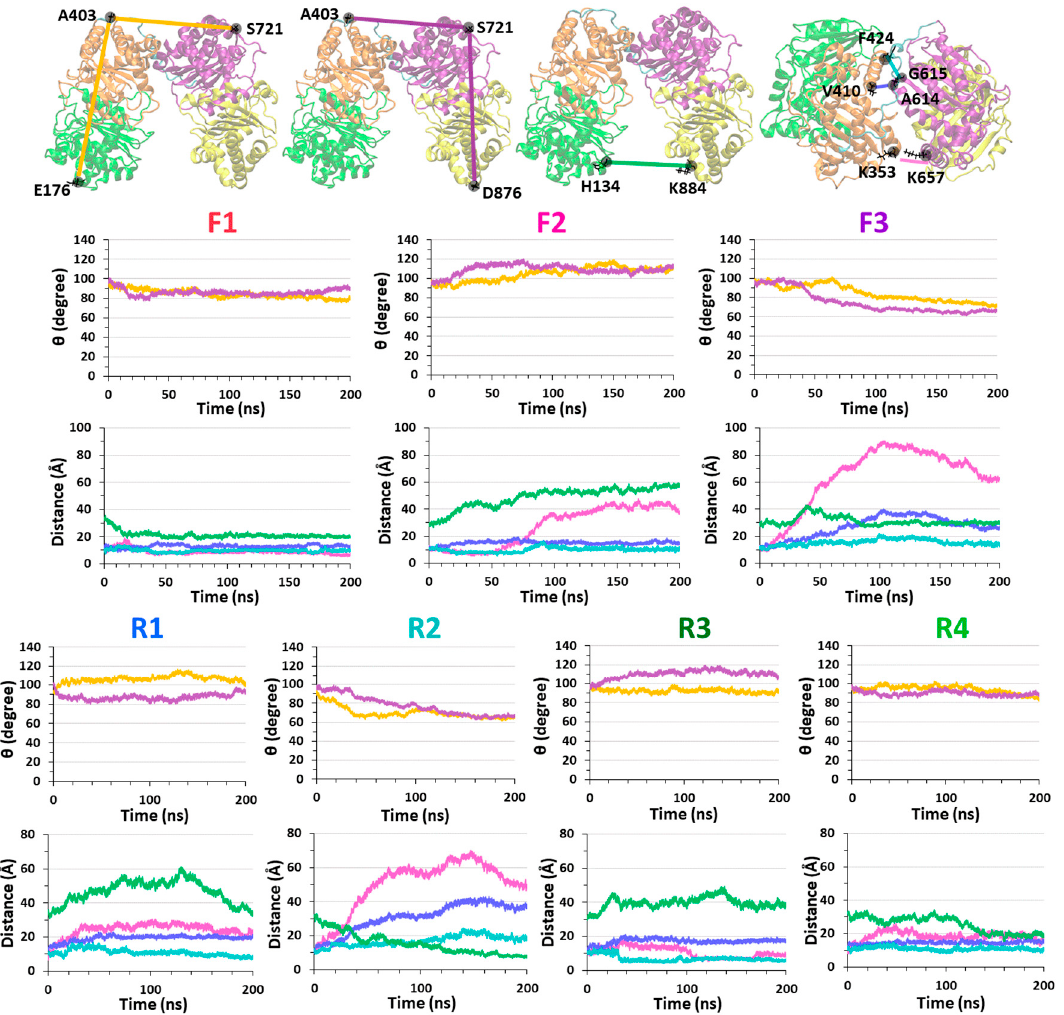
Figure 3. Measured angles [E176-A403-S721 (color: yellow), and A403-S721-D876 (color: purple)] and distances [H134-K884 (color: green), F424-G615 (color: cyan), V410-A614 (color: blue), and K353-K657 (color: pink)] within IDE that estimate the conformation of IDE (open-state / closed-state) along the MD simulations for models F1–F3 and R1–R4.